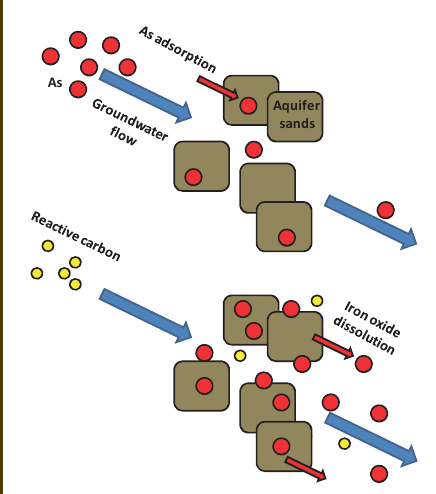
Figure 2. Conceptual representation of processes regulating the As content of groundwater. A distinction is drawn between a low-As aquifer that is contaminated by As released elsewhere (top) and locally (bottom). Groundwater flow could play a role by supplying As directly or indirectly by supplying reactive organic carbon that triggers reductive dissolution of iron